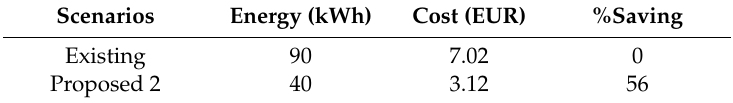
Table 3. Percentage of energy and cost saving between the proposed 2 and existing scenarios for case